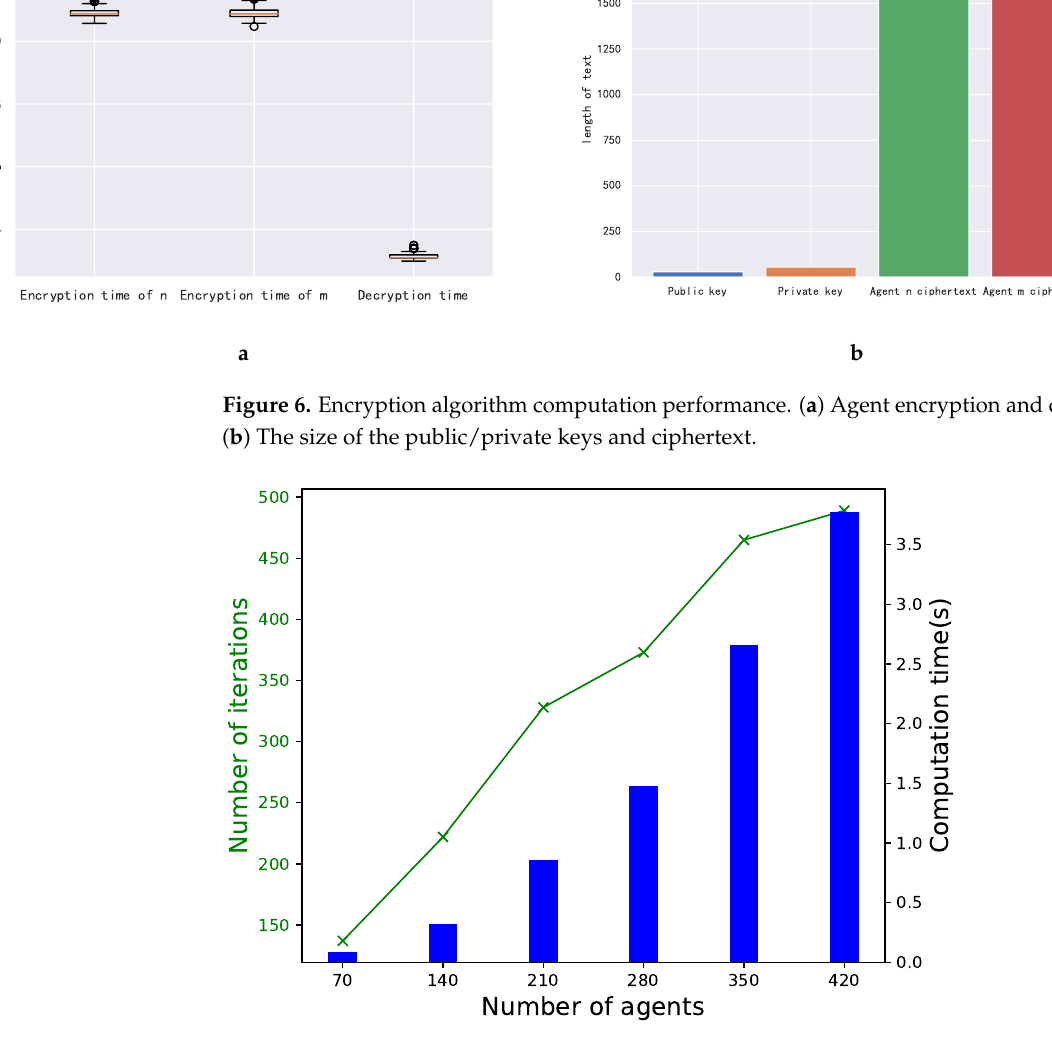
Figure 7. Impact of number of agents on computation time and number of iterations for